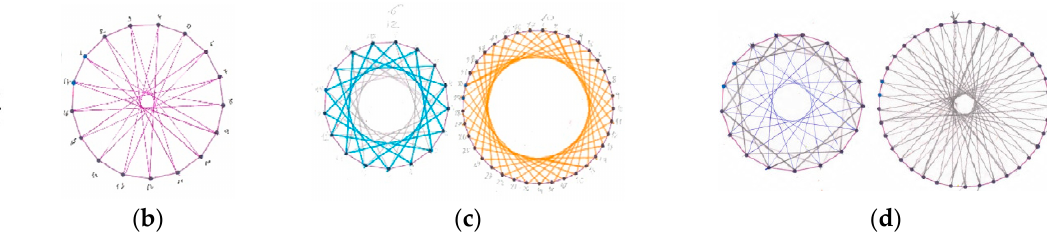
Figure 7. Star polygons. Drawing made by participant: ( a ) A4; ( b ) A5; ( c ) A6; ( d ) A7.